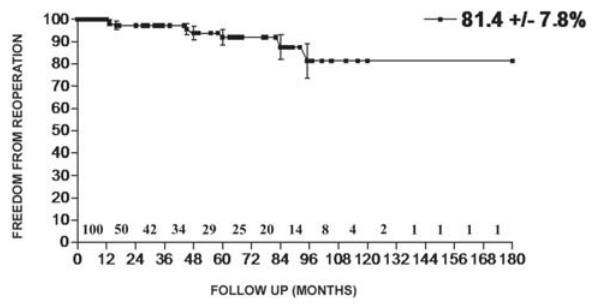
Fig. 4 - Freedom from